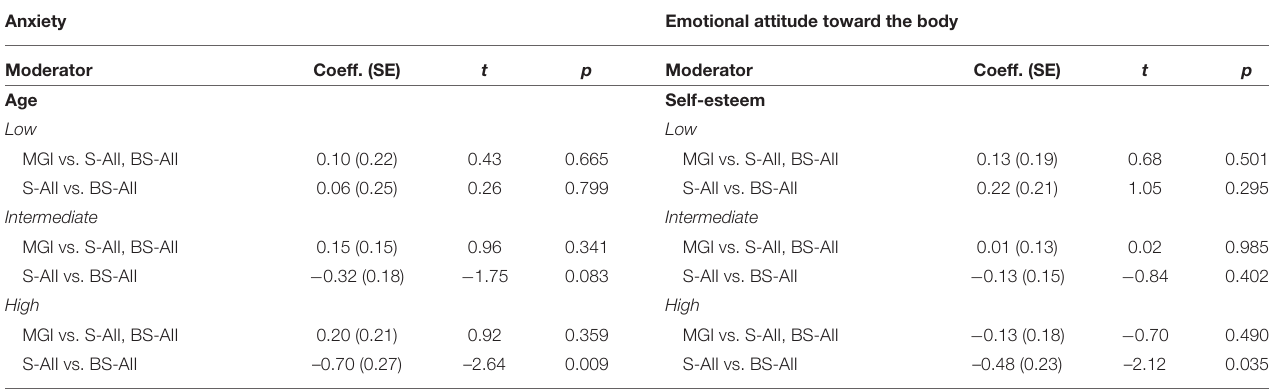
TABLE 5 | Conditional effects of the group at values of the tested moderators.